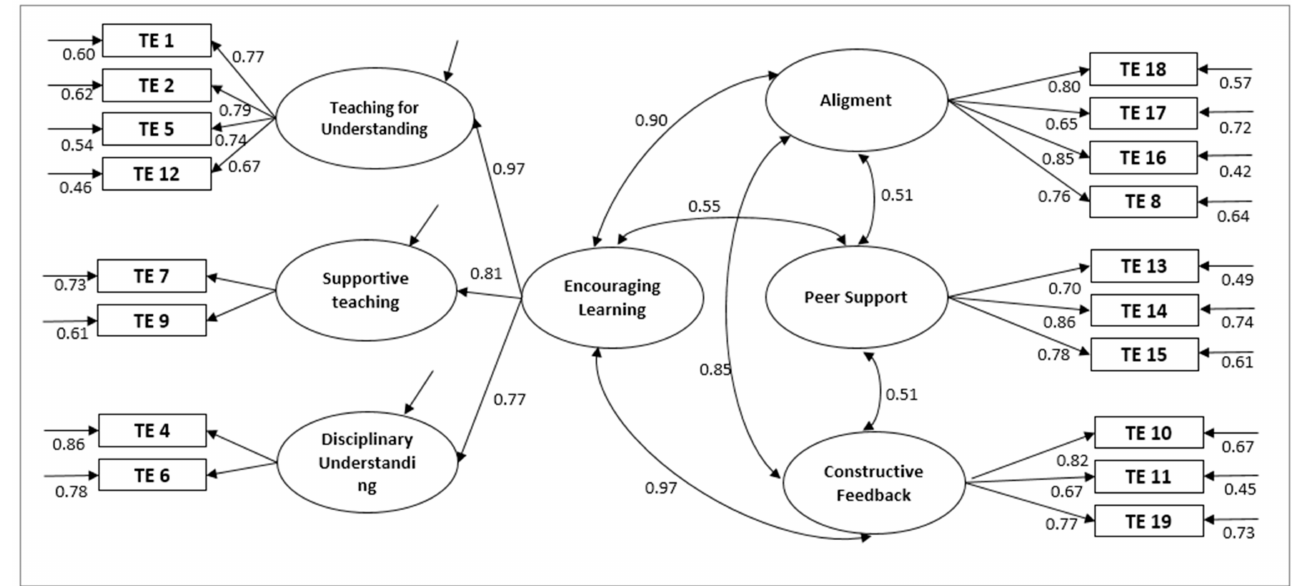
Figure 1. Original model for items and dimensions pertaining to students’ perceptions of the learning environment ( a